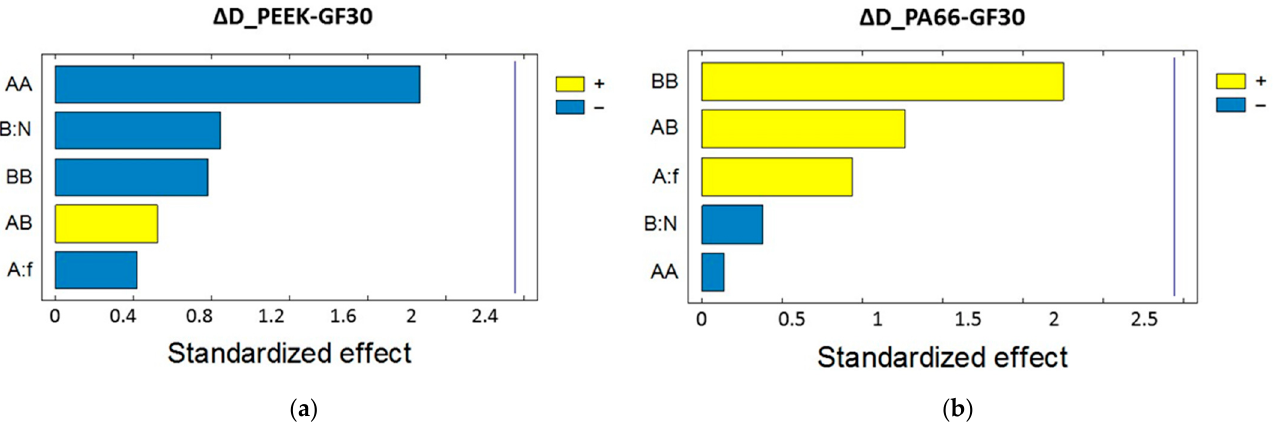
Figure 6. Standardized Pareto chart for diameter variation, at a 90% confidence level: ( a ) standardized effect for Δ D_PEEK-GF30 [dimensionless] and ( b ) standardized effect for Δ D_PA66-GF30 [dimensionless].